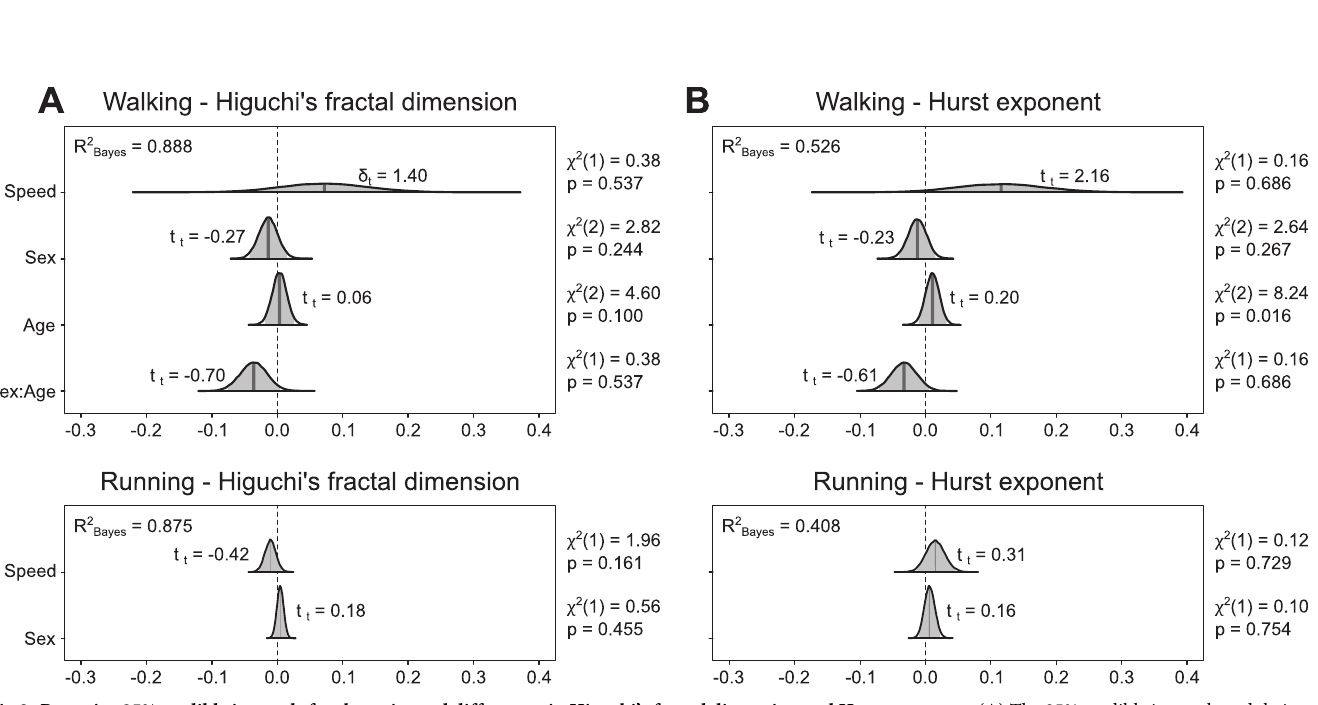
PLOS ONE | https://doi.org/10.1371/journal.pone.0269417 June 3,